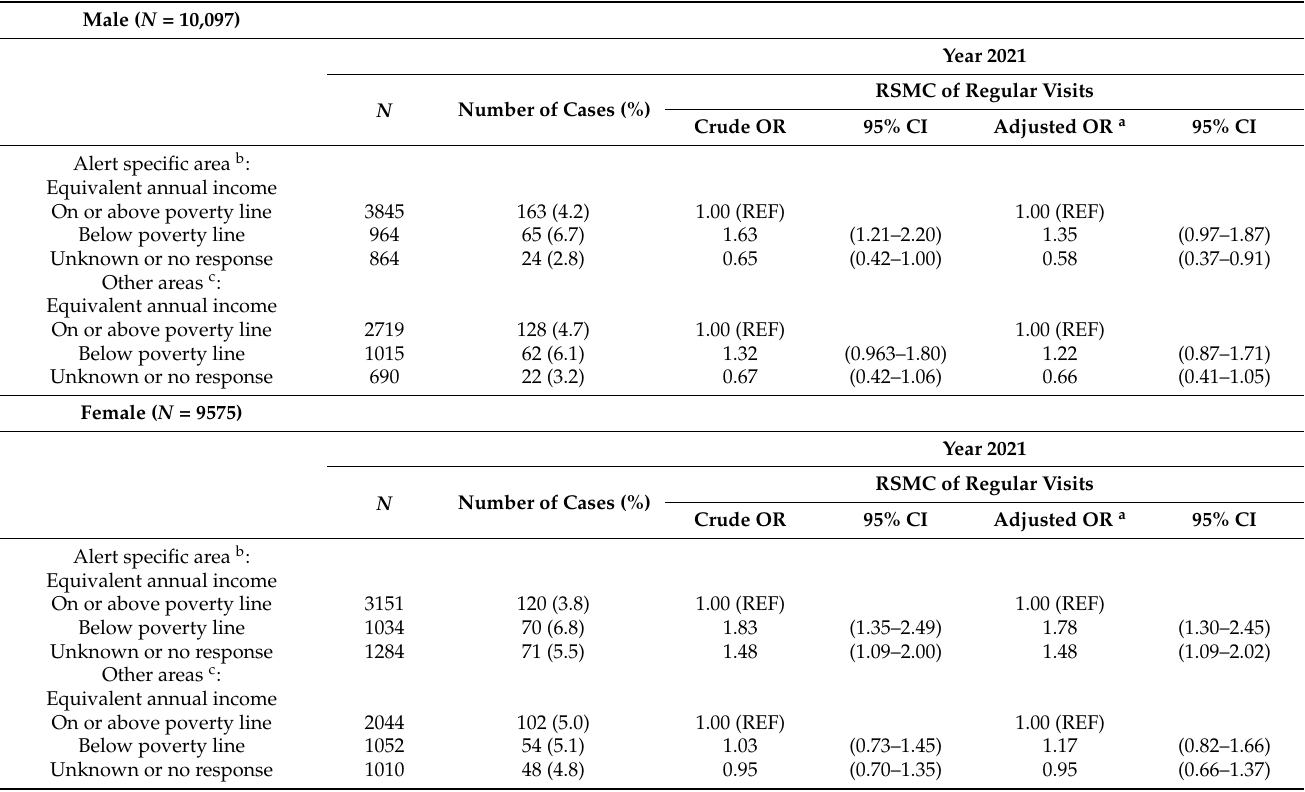
Table 4. Odds ratios (ORs) of household income for refraining from seeking medical care (RSMC) of regular visits according to specific alert